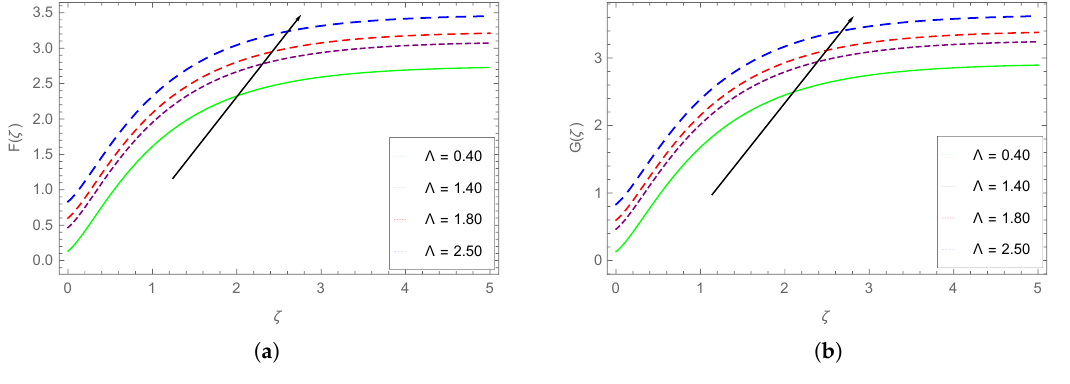
Figure 7. Impact of Λ on ( a ) F ( ζ ) and ( b ) G ( ζ )